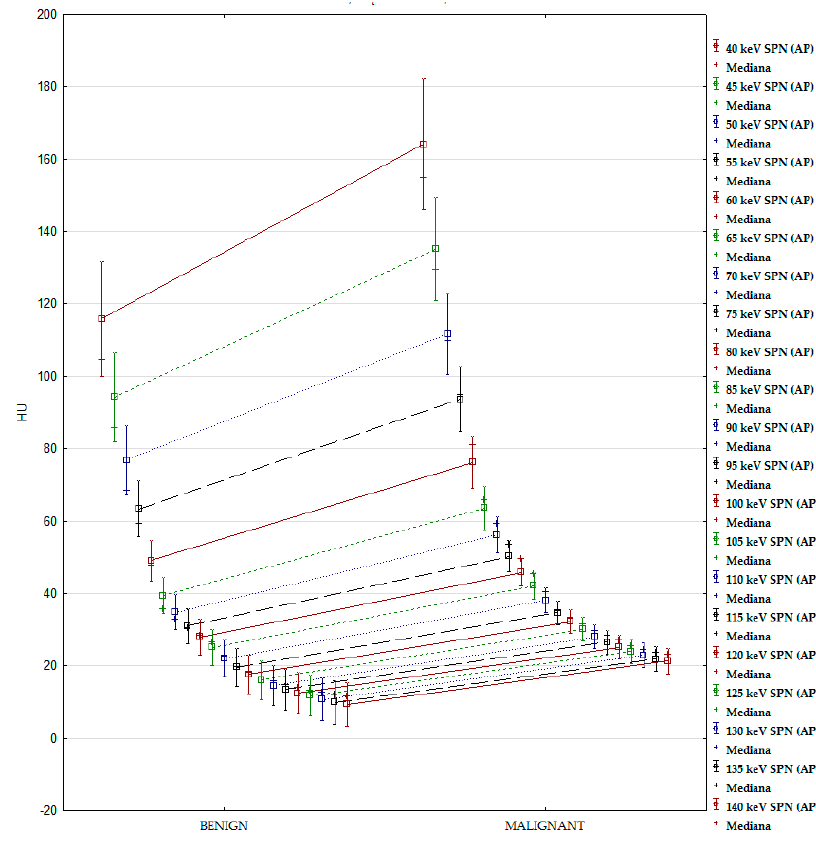
Figure A1. Distribution of the mean values of absorbed radiation measured on monochromatic images (AP) in benign and malignant nodules.